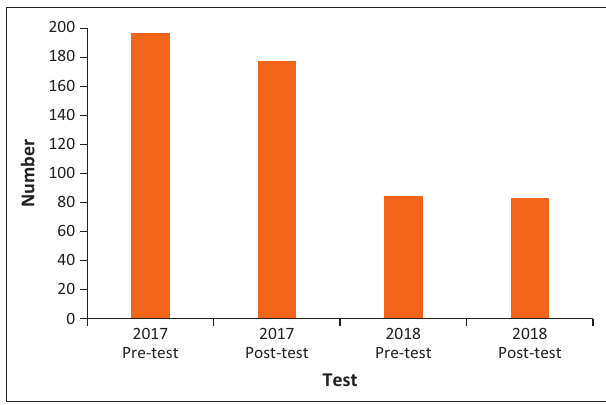
FIGURE 1: Total respondents for the year 2017 and